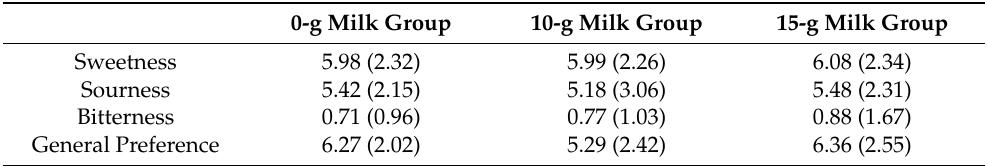
Table 5. Means of subjective rating of sweetness, sourness, bitterness, and general preference for each